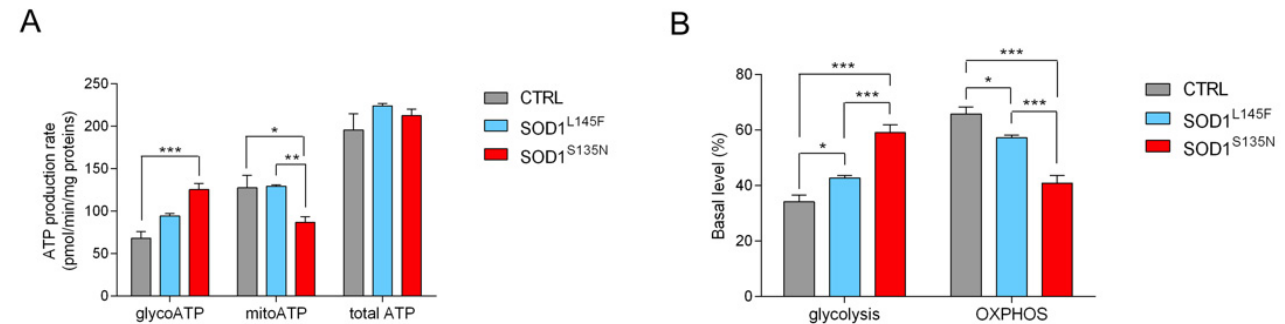
Figure 7. Evaluation of ATP production in SOD1 mutant fibroblasts. ( A ) ATP production rate expressed as pmol/min/mg protein and basal percentage level of glycolysis and oxidative phosphorylation ( B ). Data are shown as the mean ± SEM of at least three independent experiments. Statistical significance: * p < 0.05, ** p < 0.01, *** p <0.001.